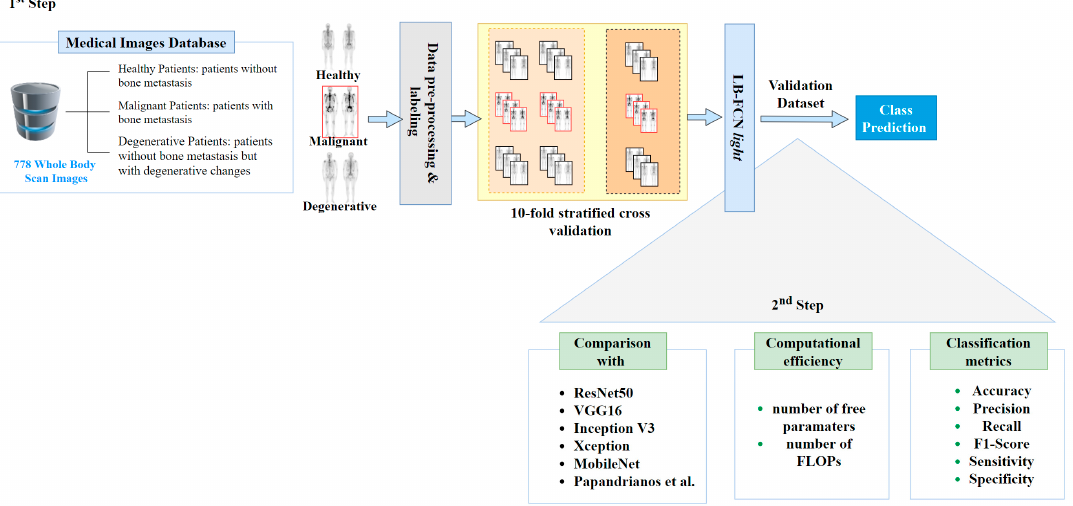
Figure 2. Methodology pipeline.